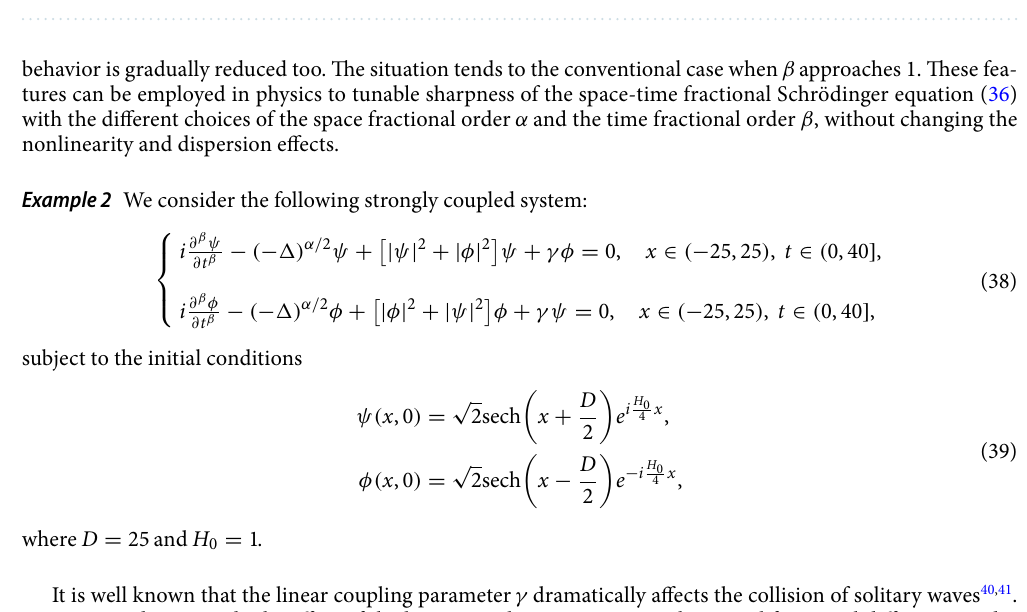
Figure 7. Numerical simulations for Example 2 with γ = 0.05 and different values of the space and time fractional